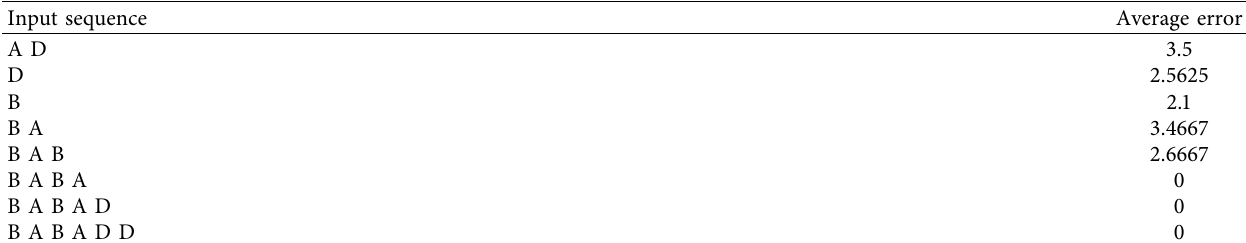
Figure 21: Output of the seq2probTree method for the tree-based system with input sequence [B A B A D D]. Table 1: The calculated average error values for different input